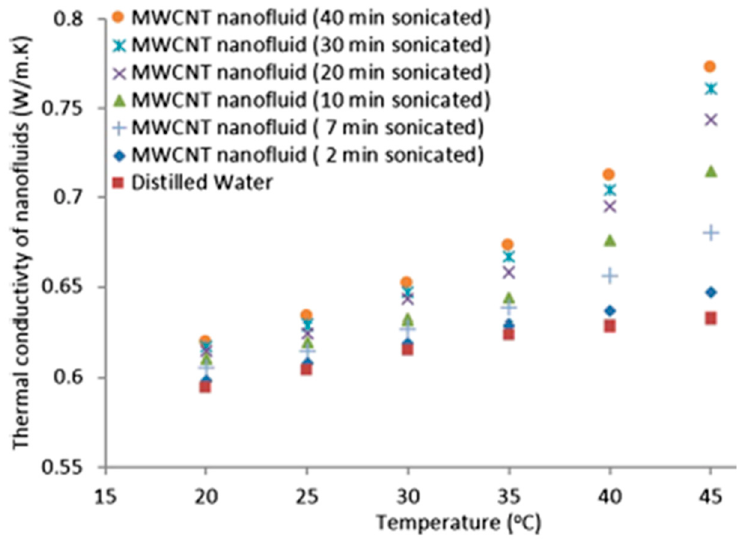
Figure 5. Effects of ultrasonication time and temperature on thermal conductivity of nanofluids [126].